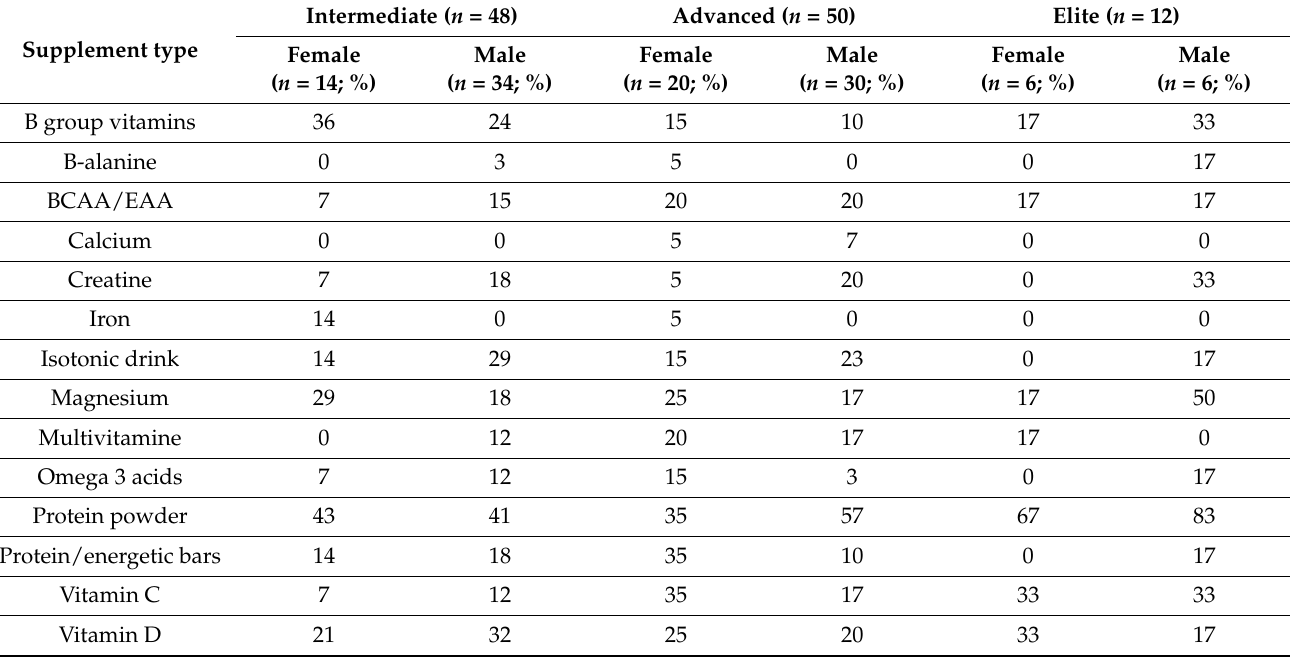
Table 3. Self-reported nutritional supplement and product use to support climbing performance in the last 6 months (proportion of each cohort